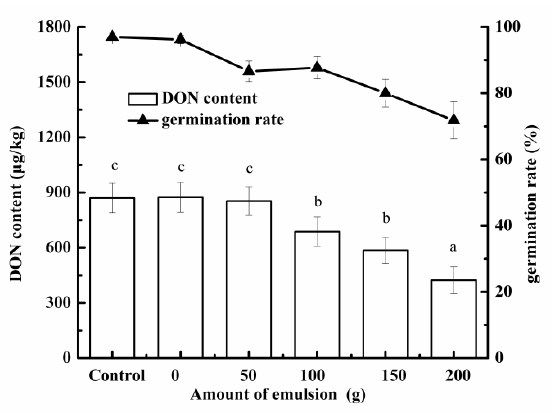
Figure 9. Effect of adding secondary emulsion during third soaking on germination rate of barley and DON content in malt.